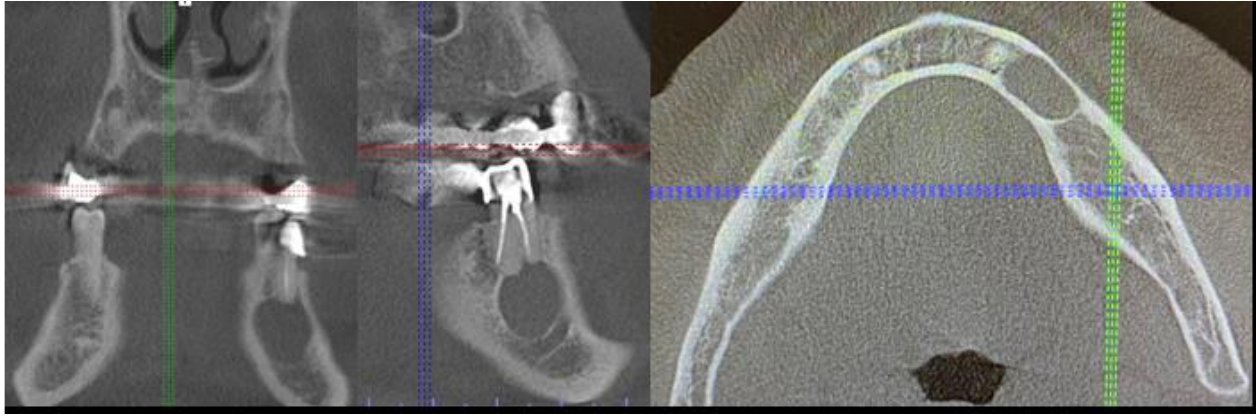
Figure 4. The sagittal, coronal, and axial view of the cystic lesion in the left mandibular basis.